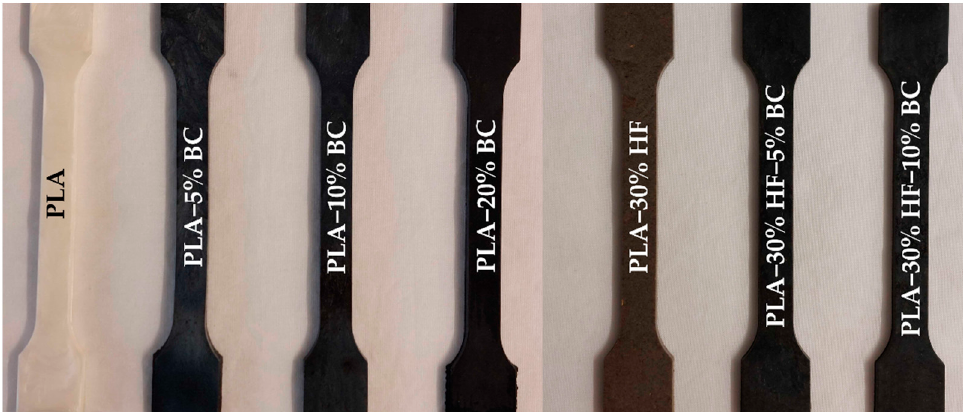
Figure 1. PLA and reinforced PLA composites . Table 3. Surface color analysis results of PLA-based composites according to the CIELAB color system (CIE L*, CIE a* and CIE b* coordinates) .